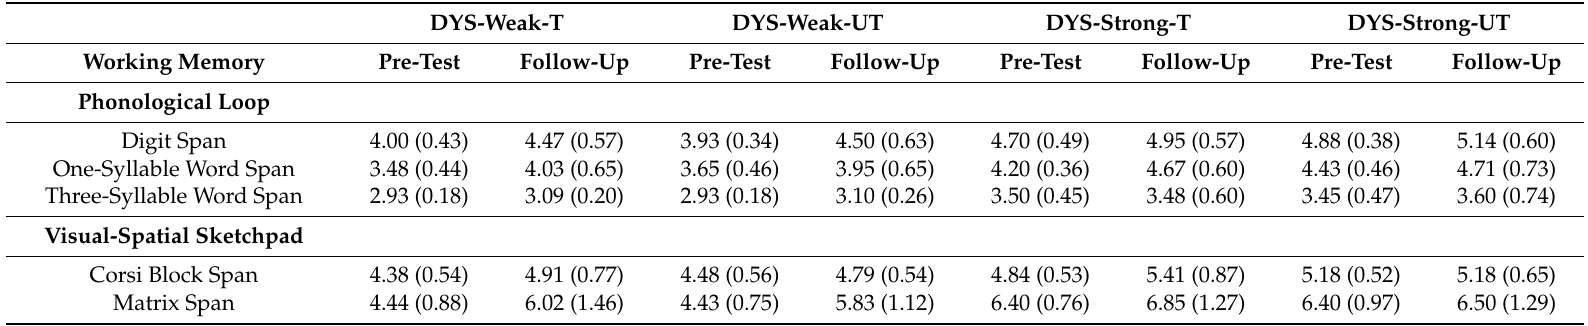
Table 3. Means (standard deviations) for working memory measures by